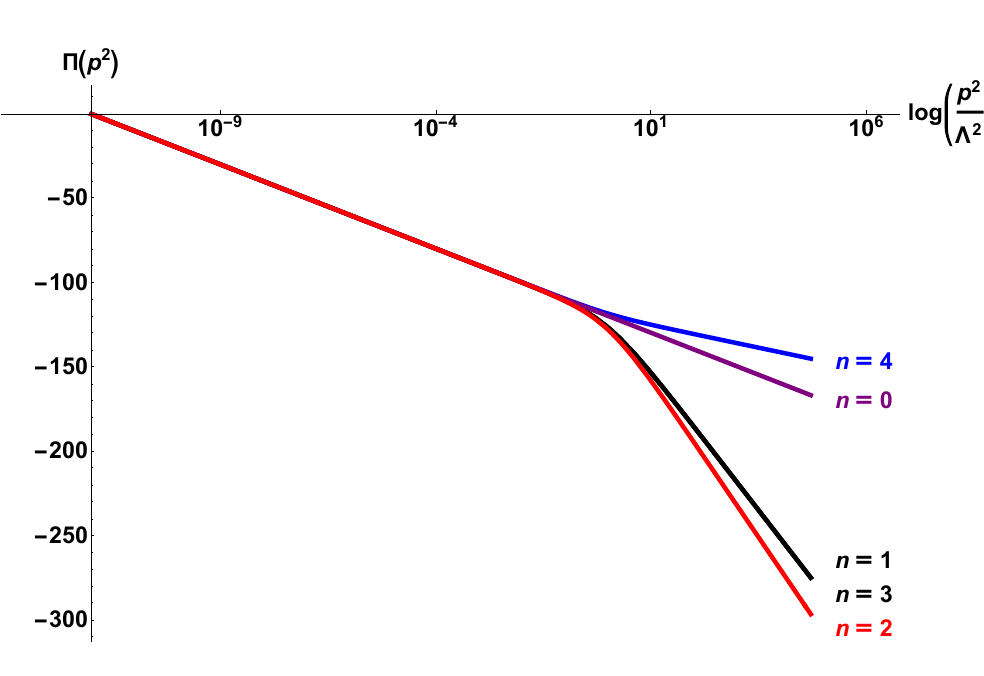
Figure 1 . Momentum dependence of one-loop radiative corrections to the 2-point function form factor Π( p 2 ) for different higher derivative theories. The cases n = 1 and n = 3 give rise to the same form factors. The results for large momenta are independent of the gauge fixing parameter α , whereas in the IR we used a Lorentz gauge with α = 0 . In the infrared regime Λ QCD < p (cid:28) Λ , the behavior is independent on the number of extra derivatives and agrees with that of standard gauge theories. In the UV regime p (cid:29) Λ , the behavior depends on the number of extra derivatives, but in all five cases the theory is asymptotically free. We assumed that the higher derivative scale Λ is of the order of 100 TeV, i.e. Λ ≈ 10 6 Λ QCD